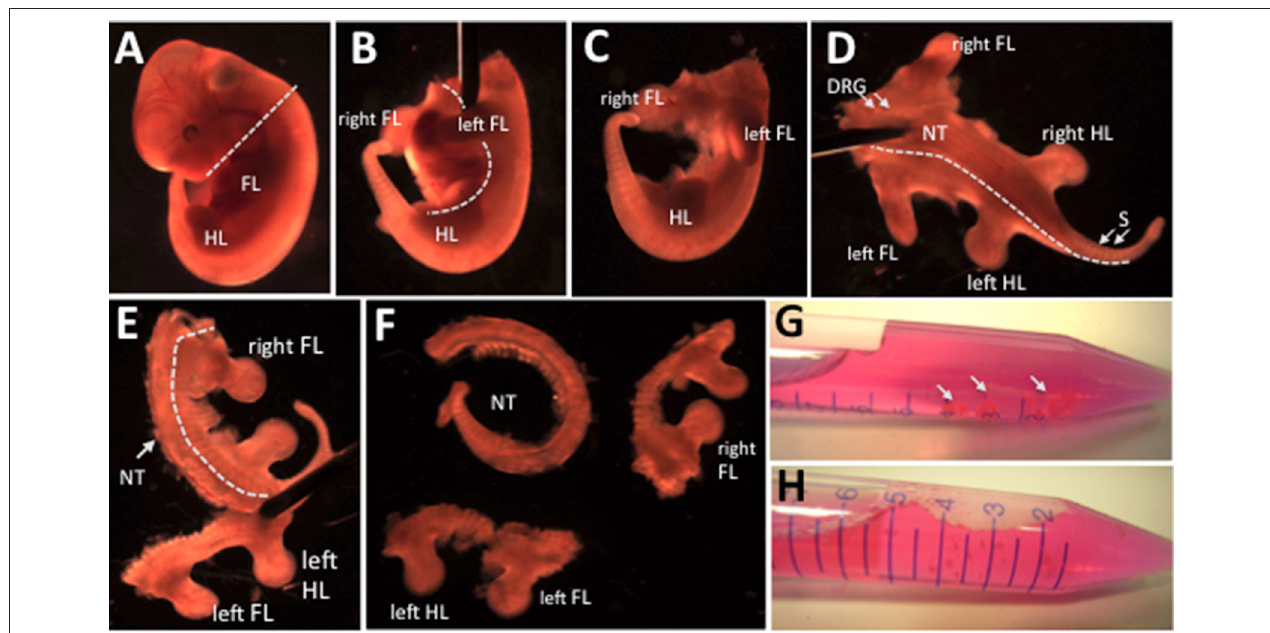
FIGURE 5 | Progressive dissection of an E11.5 embryo. (A) The head of the embryo is removed. (B) After placing the embryo on one side, the internal organs laying between the upper (FL) and lower (HL) limbs are removed by using needles. (C) Photo of an E11.5 embryo after removal of the internal organs presenting intact FL, HL, and lateral body wall. (D) After placing the embryo with the ventral portion facing down, needles are used to cut the embryo cranio-caudally (dashed line) lateral to the dorsal root ganglia (DRG) and neural tube (NT) and medial to the somites (S). (E) The operation described in (D) is repeated on both sides of the NT. (F) The embryo (divided into a right and left portion) is dissected free from the NT. (G) The isolated portions the embryos are placed in a 15ml tube containing digestion solution. (H) Through vigorous shacking embryonic tissues are disaggregated in small ( < 1 mm 3 )